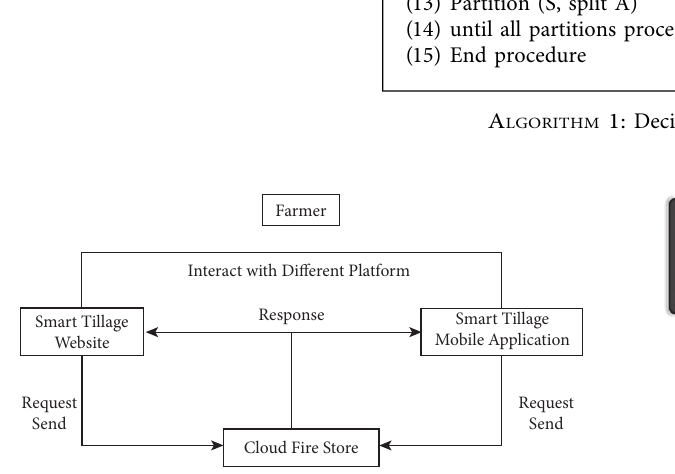
Figure 7: Layout of smart tillage framework.